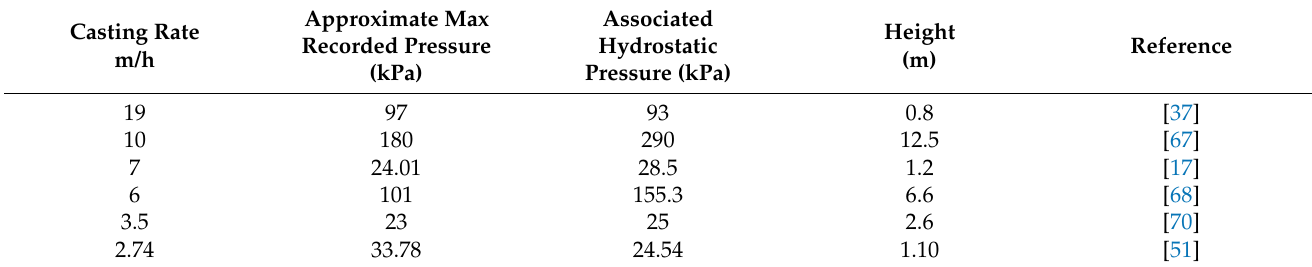
Table 2. The influence of casting rate on the formwork pressure for different mix designs.